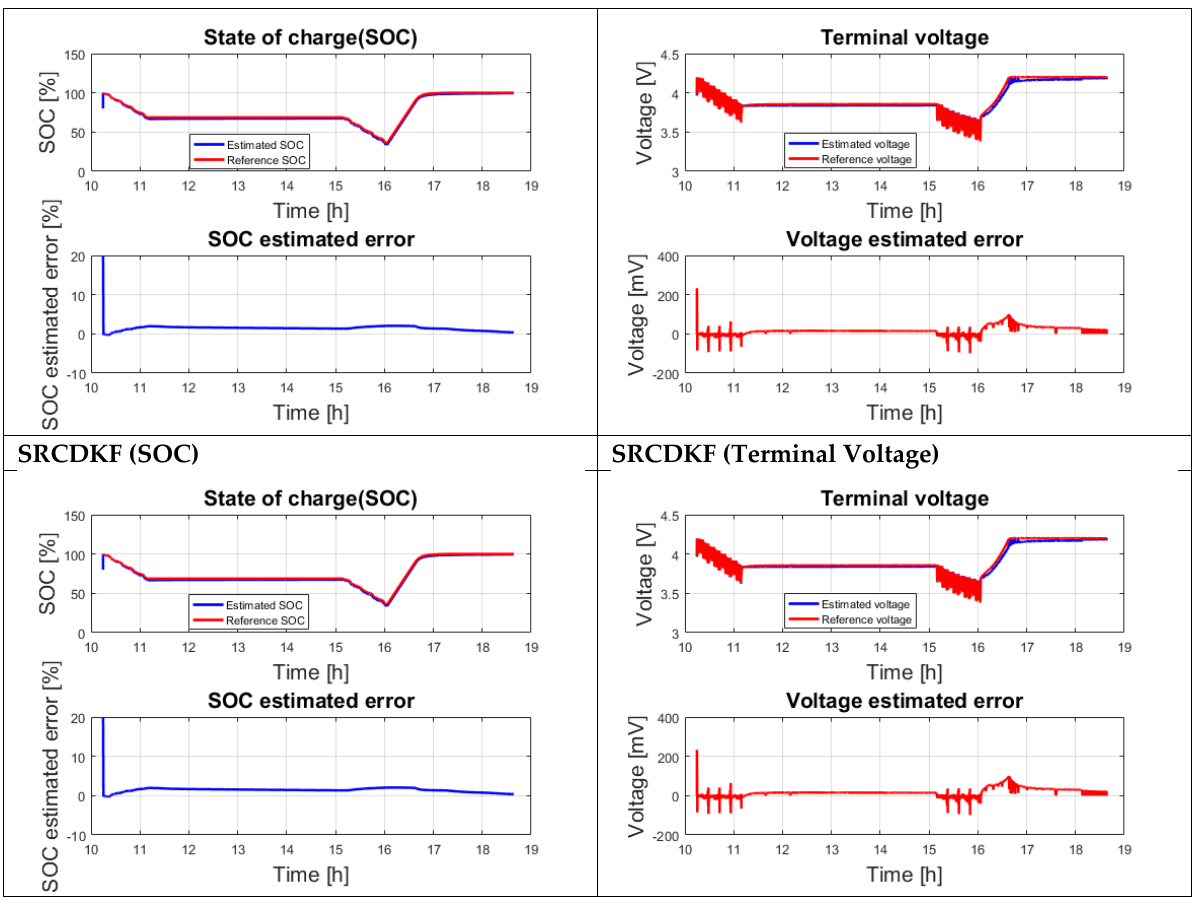
Figure 13. SOC estimation of different filters. Table 4. Result comparison for model